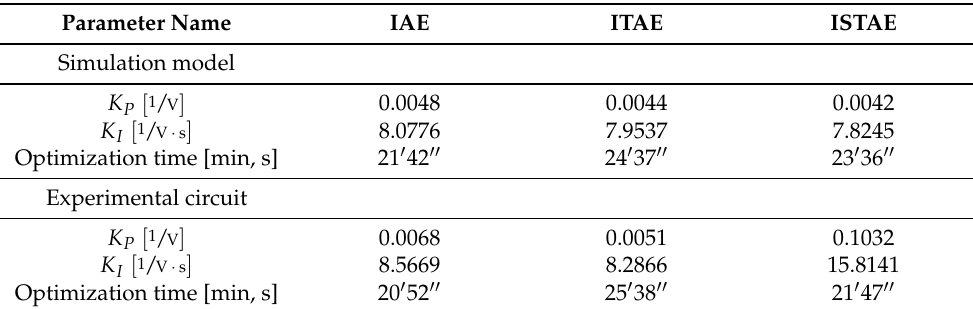
Table 4. Calculated values of PI regulator K P and K I gains together with their GA computation times where the GA was constrained by the global stability regions ( GM = 0 dB and PM = 0°) shown in Figure 7 for simulation and in Figure 8 for experiment.